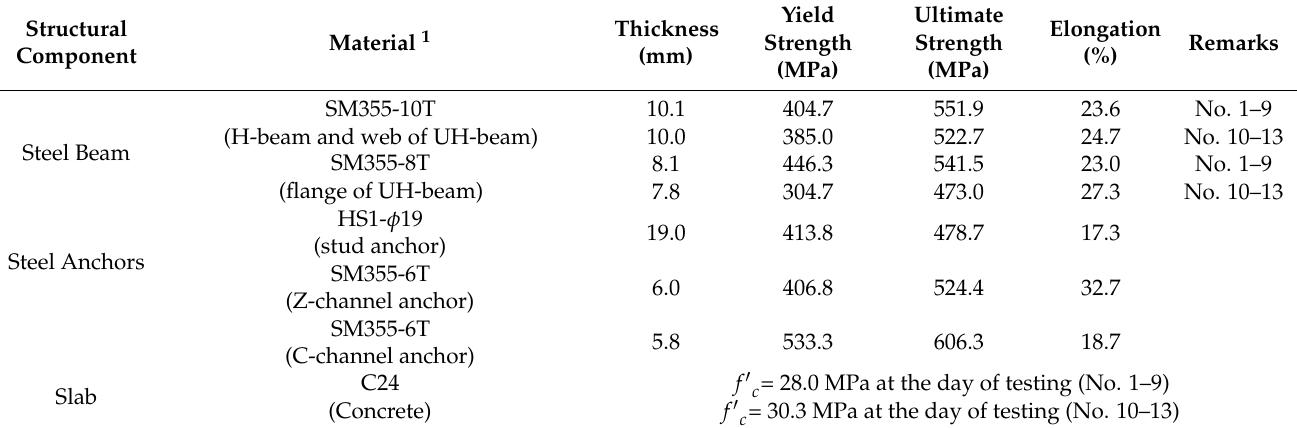
Table 2. Measured material properties.